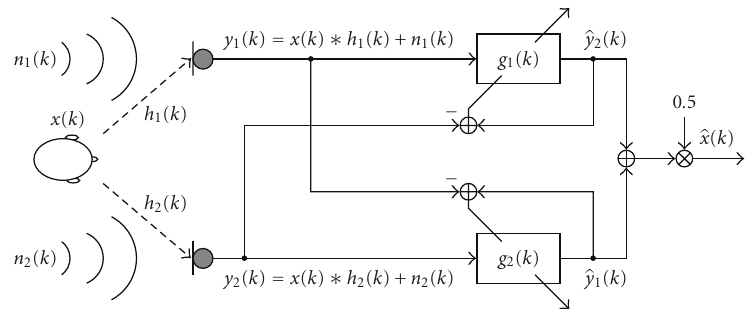
Figure 4: Basic system structure of the LMS